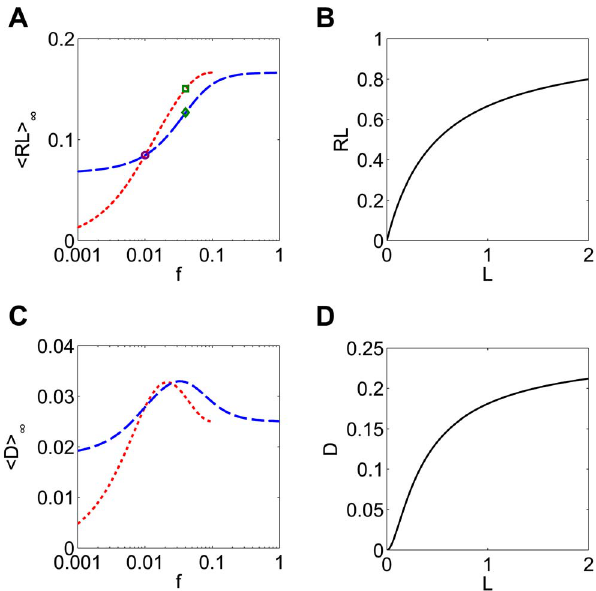
Figure 3. The frequency response differs for systems with different steady state nonlinearity. ( A ) The ligand-receptor binding model exhibits a monotonic-increasing mean concentration of mean bound receptor ( , RL . ‘ ) to both amplitude and duration compensated signals (red dotted and blue dashed curves, respectively). The circle, square, and diamond indicate the mean response to the signals shown in Figure 2. Note that for amplitude compensated signals, the fixed duration d 0 =10 limits the maximum frequency to f=0.1. ( B ) The steady state fraction of bound receptors (RL) is a monotonic increasing, concave function of the input ligand concentration (L). ( C ) Adding receptor dimerization to the system results in bell-shaped responses of mean level of dimer ( , D . ‘ ) to both amplitude and duration compensated signals (red and blue curves, respectively). ( D ) The steady state level of dimer (D) is a sigmoidal function of the input ligand concentration. For (A) and (C), A 0 =1 and d 0 =10 at frequency f 0 =0.01 for both amplitude and duration compensated